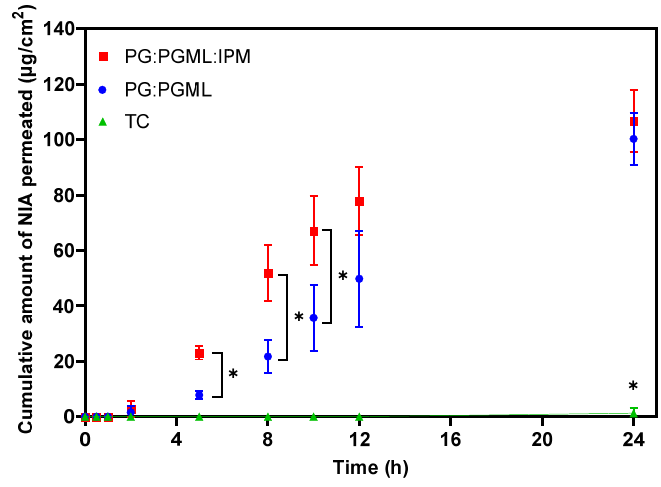
Figure 1. Cumulative permeation of NIA over time for various solvent systems in the human epidermis (4 ≥ n ≥ 3; mean ± SD, one-way ANOVA, * p < 0.05).